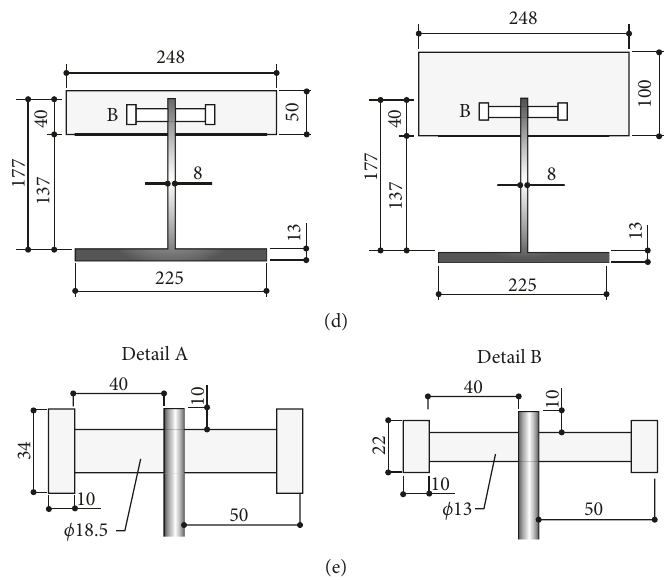
Figure 2: Sectional dimensions and details of test members (unit: mm). (a) Overall dimensions of composite beam members; (b) original 120MPa and 150MPa test members; (c) modified 120MPa and 150MPa test members; (d) 180 MPa test members; (e) details of studs for 120MPa and 150MPa members (left) and for 180MPa members (right).